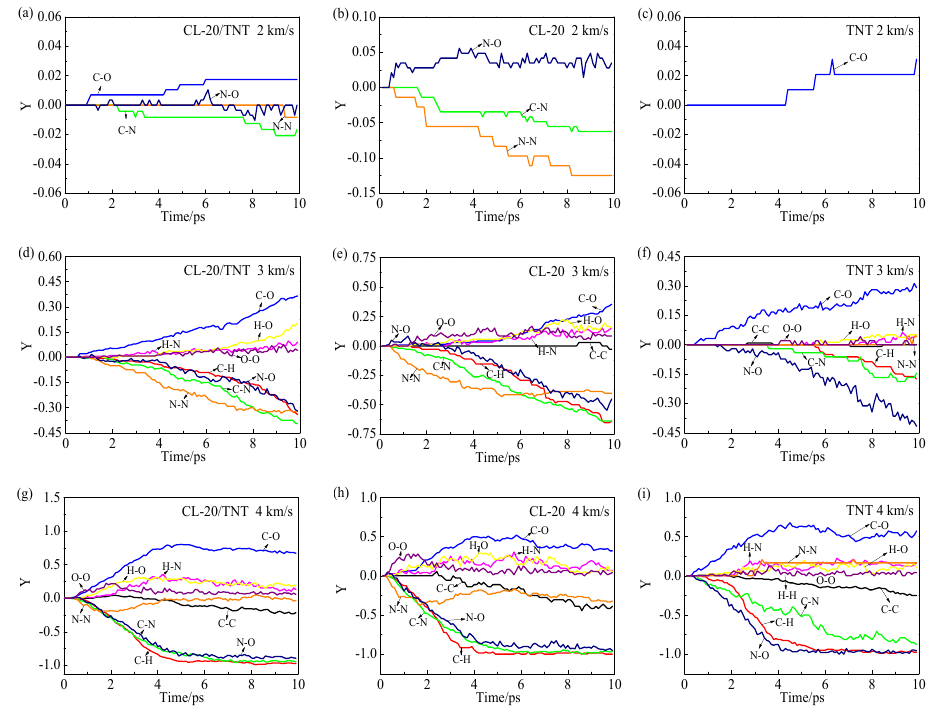
Figure 5. Formation and fracture numbers of the different types of chemical bonds in the CL-20/TNT, CL-20 and TNT crystals with time at impact velocities of ( a – c ) 2 km/s, ( d – f ) 3 km/s and ( g – i ) 4 km/s. Table 4. Initial changes of the chemical bond types in the CL-20/TNT, CL-20 and TNT crystals at different impact velocities *.